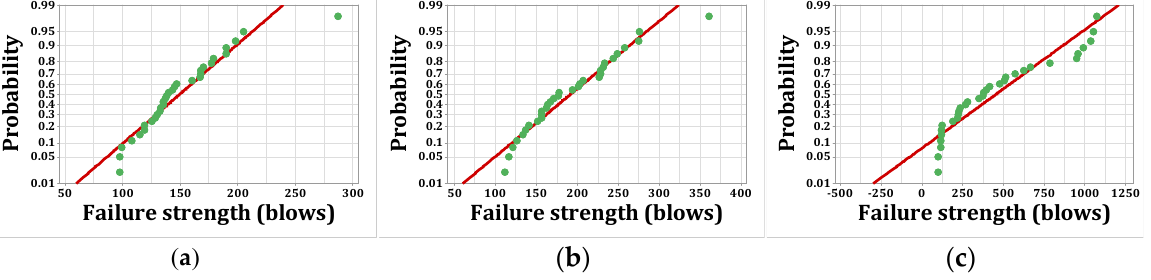
Figure 21. Normal probability plots for failure strength (humid): ( a ) R, ( b ) F2, ( c ) F3.